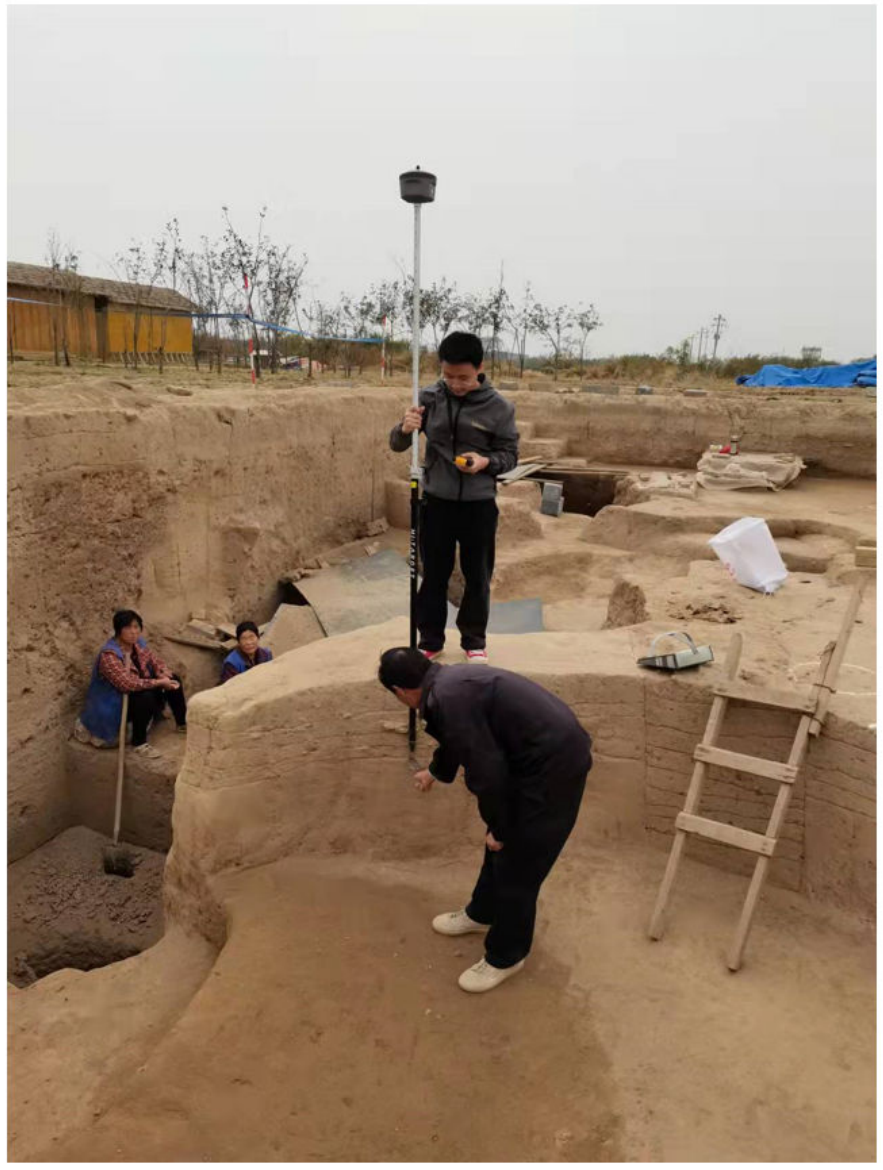
Figure 7. Collection of spatial information from earlier site